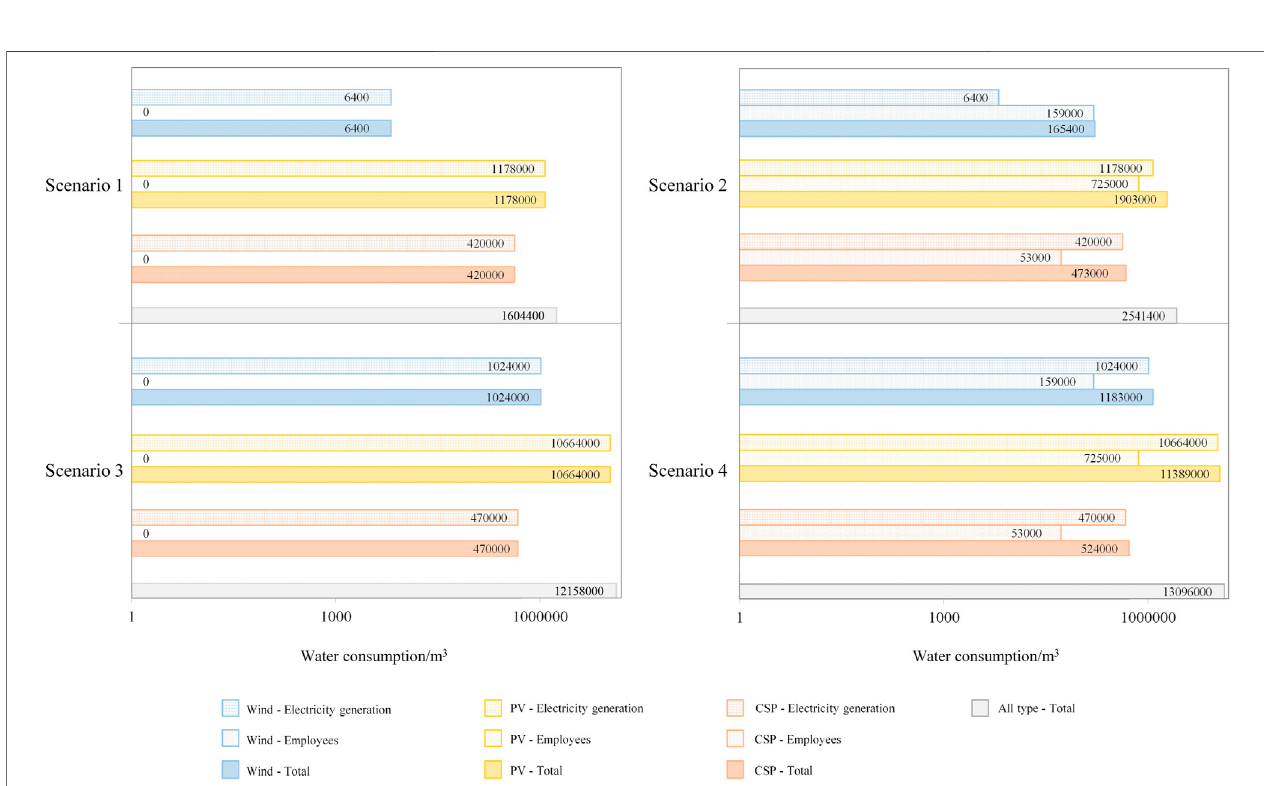
FIGURE 4 | Water consumption by renewable energy enterprises in Golmud under current